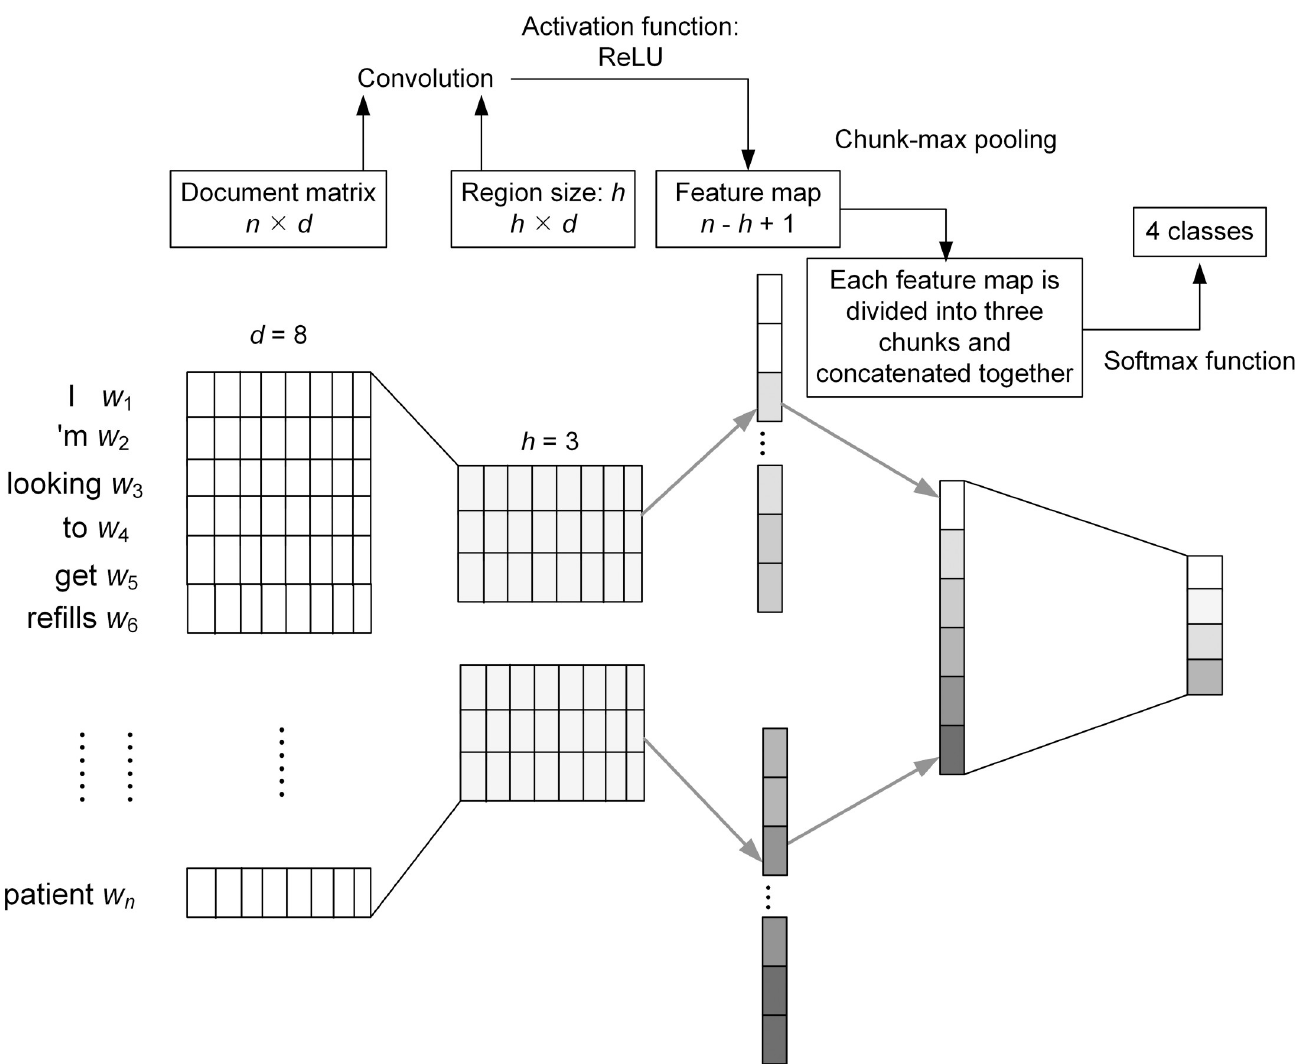
Fig 3. A CNN model with chunk-max